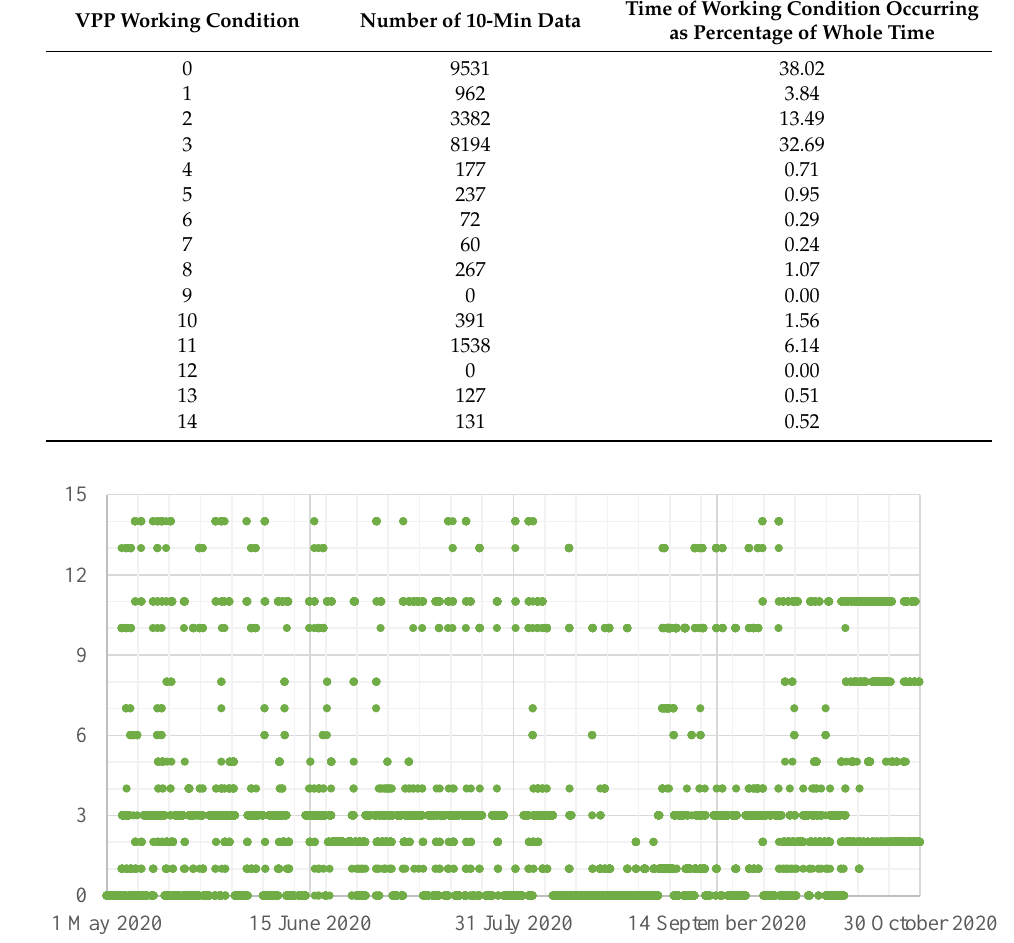
Figure 7. VPP working conditions in analyzed period of time.